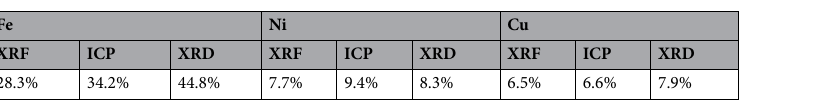
Fe Ni Cu XRF ICP XRD